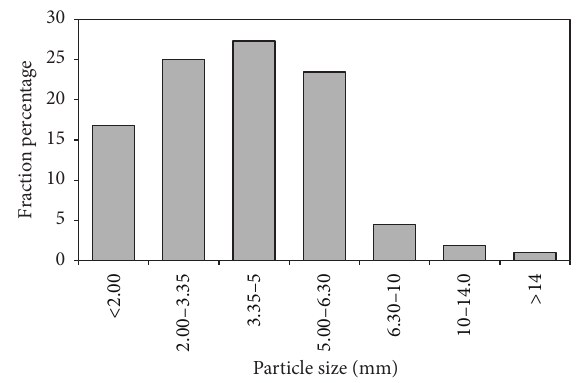
Figure 1: Particle size distribution of the wasted black